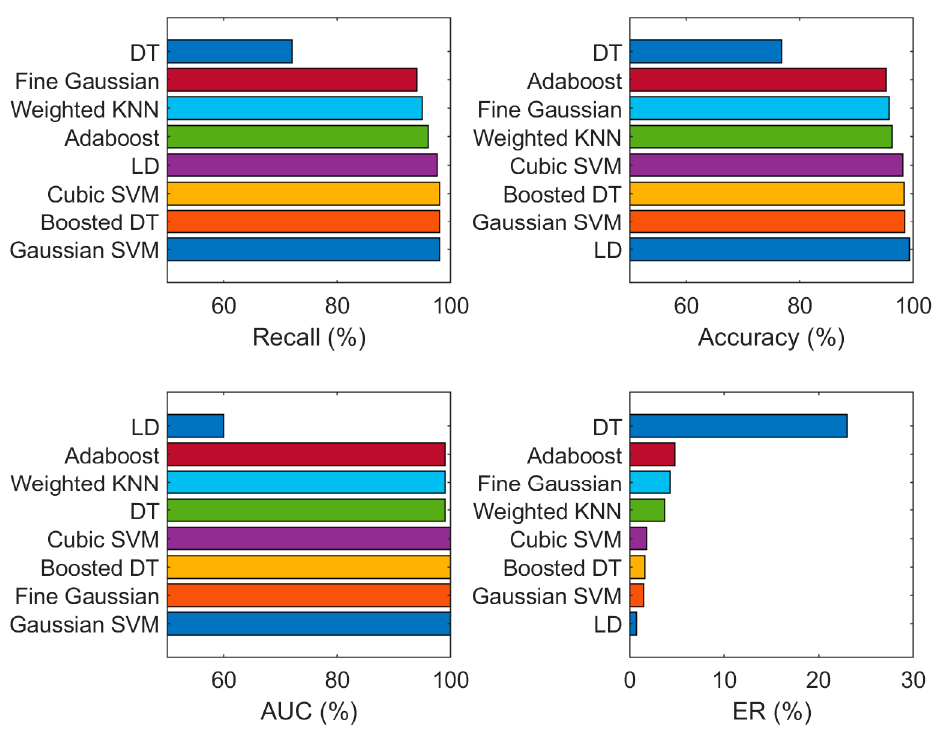
Figure 8. Classification results (recall, accuracy, AUC, and ER) using SFTA features on the balanced (augmented) dataset.